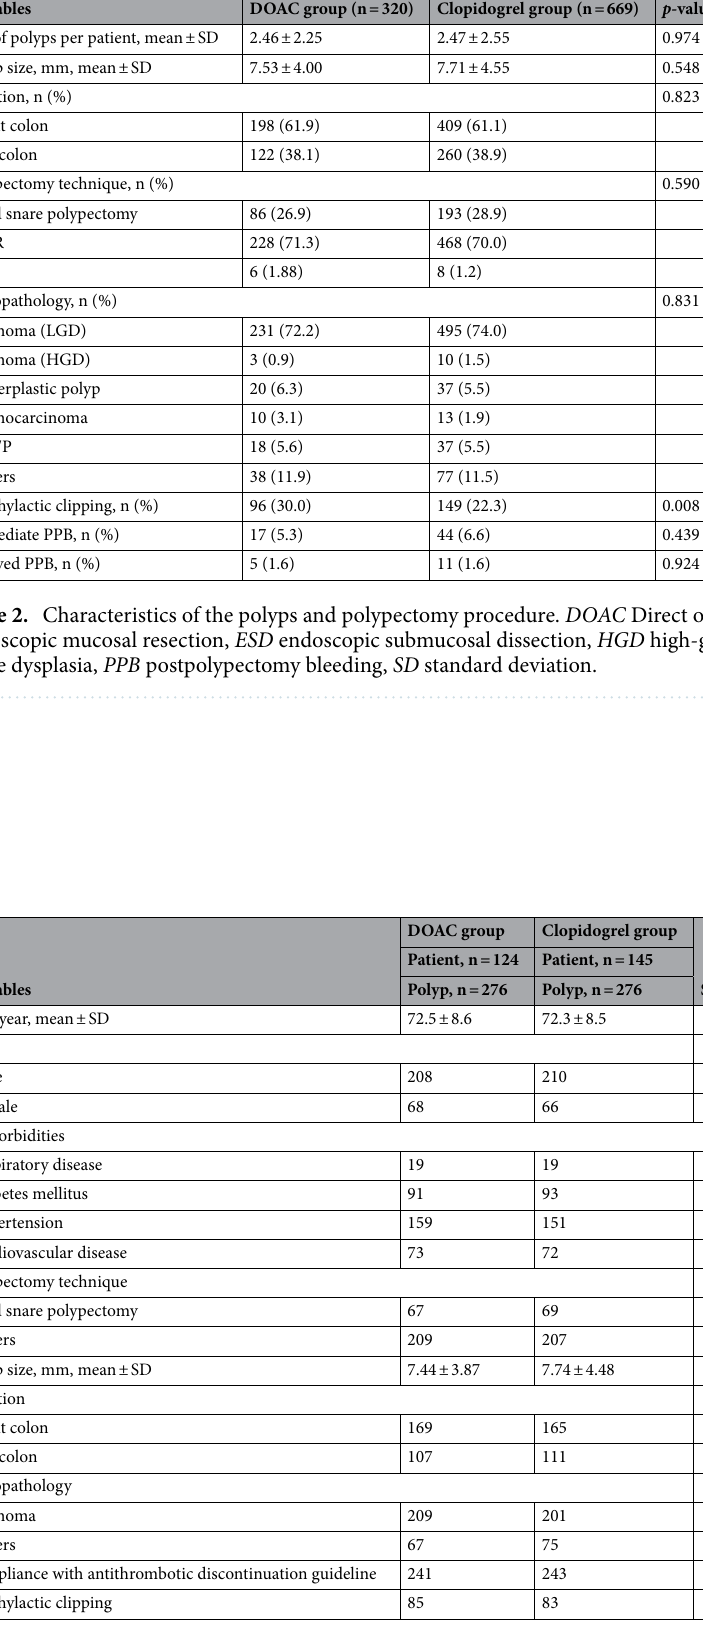
Table 3. Characteristics of the 552 propensity score-matched cases. DOAC Direct oral anticoagulant, SD standard deviation, SMD Standardized mean